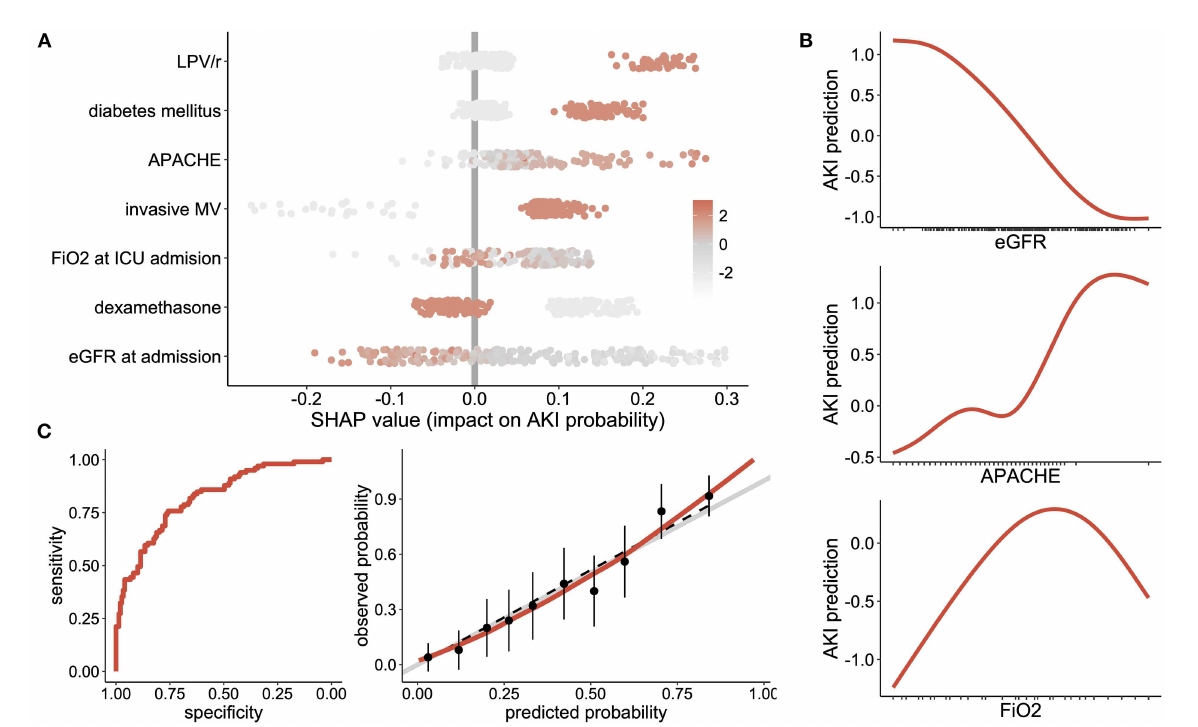
FIGURE1 AKI associated factors: (A) Shapley Additive Explanation (SHAP) values, where one dot represents the importance of each variable for AKI risk at the single patient level. Positive values reflect an increased risk of AKI while negative values show a negative effect on AKI risk. The sum of all SHAP values from one patient represent the predicted AKI probability for this patient. Each dot is color coded according to the patient’s initial value for each considered feature. (B) Partial dependence plots, showing the effect of eGFR, APACHE score and FiO2 at ICU admission on the risk of AKI. (C) evaluation of the generalized additive model with the receiver operating characteristic curve (left panel) and the calibration plot (right panel) showing sensitivity according to the specificity and the observed vs. predicted probabilities, respectively. LPV/r Lopinavir/Ritonavir, DM Diabetes Mellitus; DXM Dexamethasone; MV Mechanical